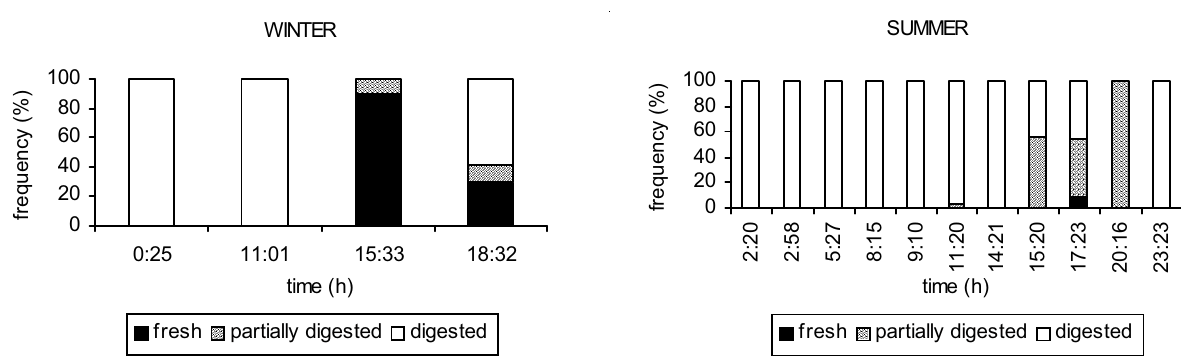
Fig. 6. Proportion of the state of digestion of stomach content of Trachurus lathami by sampling period from Ubatuba shelf, in winter (22-24/07/1988 - 23 o 35.6´S/ 44 o 59´W) and summer (04-06/12/1988 - 23 o 51.3´S/44 o 47.6´W).